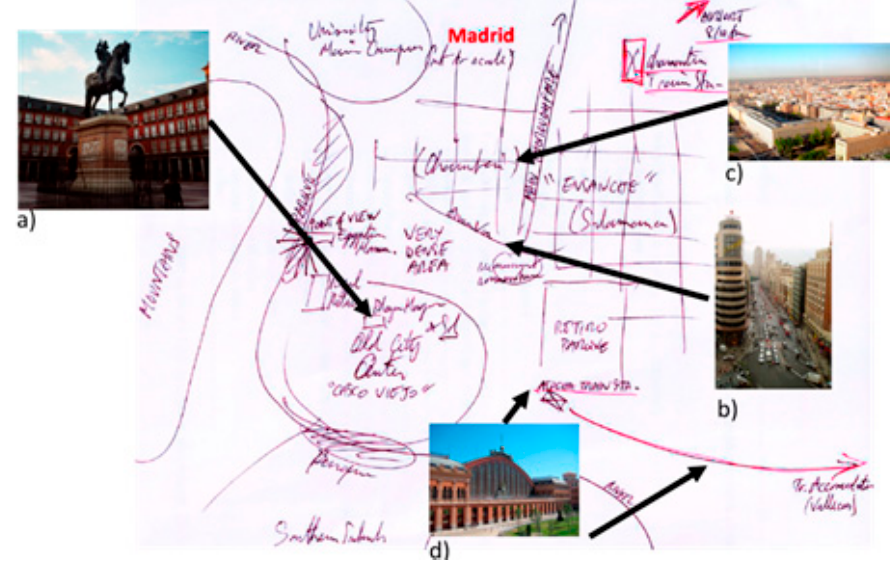
Figure 3. Sketch of Madrid drawn by a tourist. It shows: ( a ) Plaza Mayor; ( b ) Gran Vía street; ( c ) Chamberí zone; and ( d ) the Atocha train station and subway. Table 1. Individual and contextual factors, profile, and final sketch of tourists who wrote diaries.